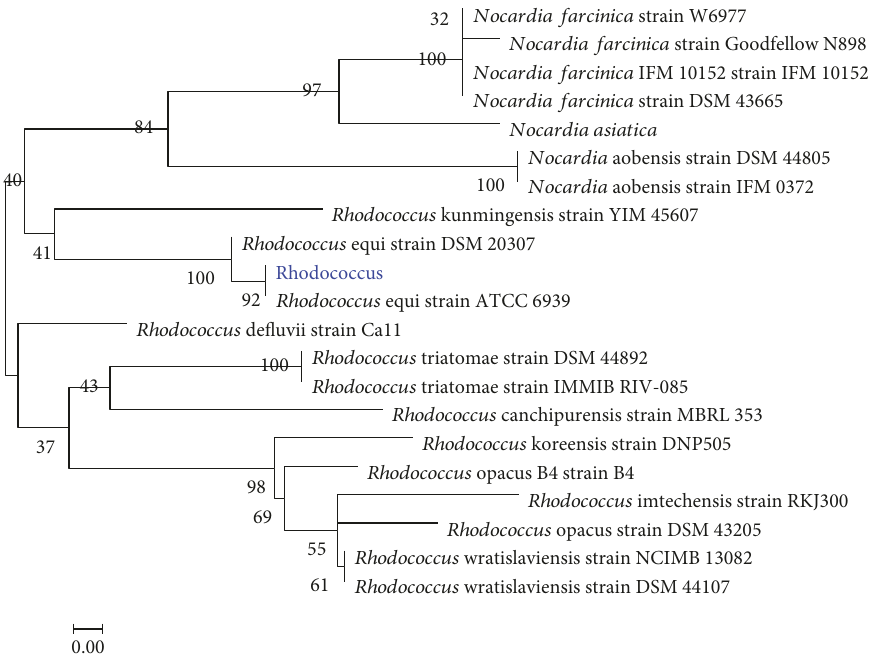
Figure 2: Evolutionary tree based on the 16S rDNA